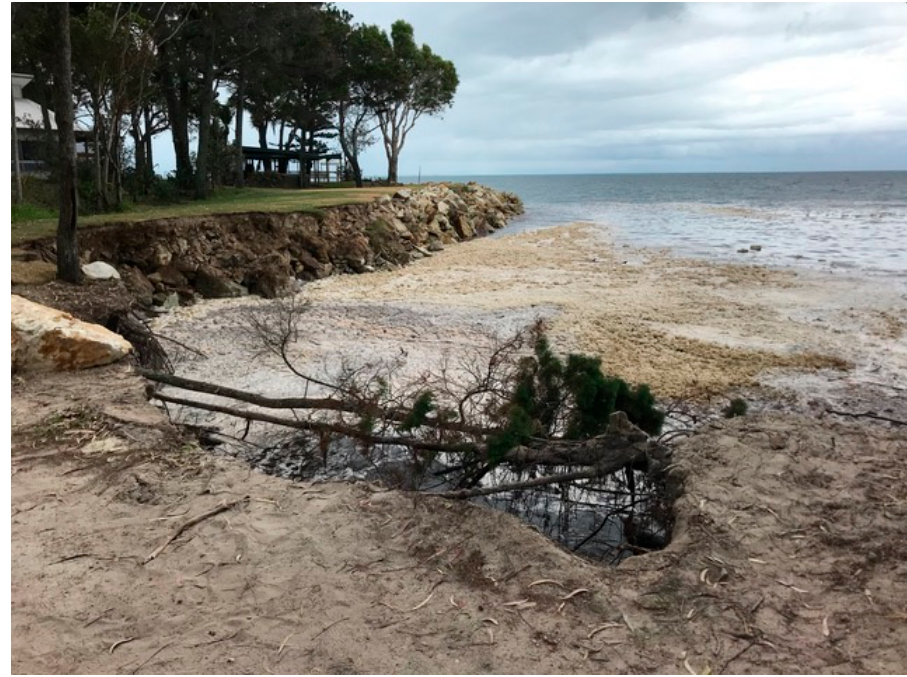
Figure 9. Damage after an RBF event at Amity Point (2017), including slumping of the ‘flow slide barrier’. Note that heavy foam is a common feature of events at this site. Photo: Beinssen.